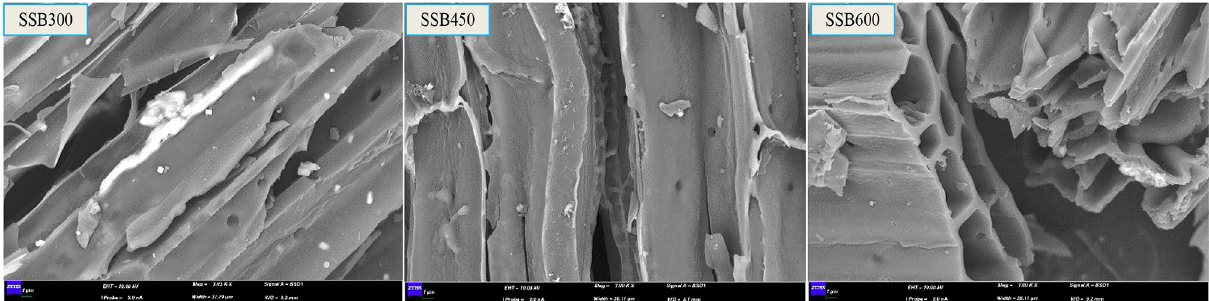
Figure 1. Scanning electron micrograph of biochar at different carbonization temperatures.